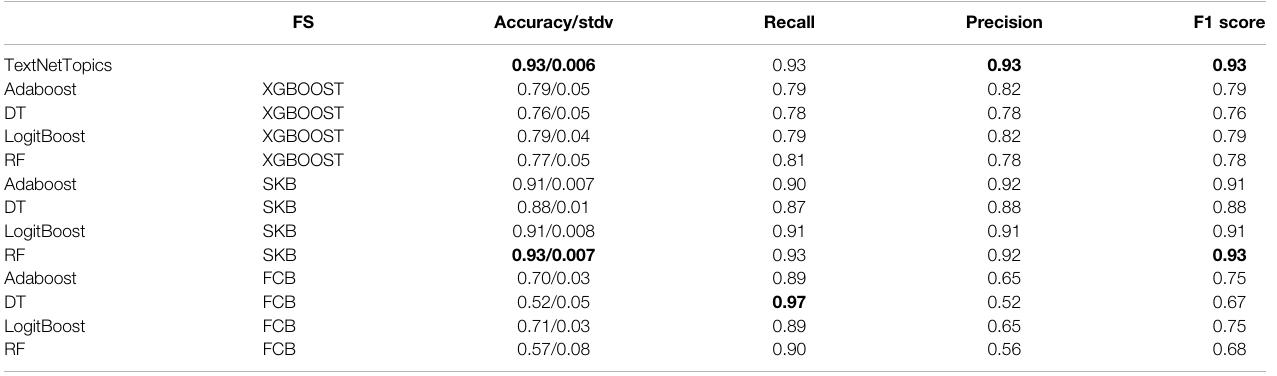
TABLE 6 | Results for different algorithms with different feature selections applied to the CAMDA dataset. The top 100 features are considered for each feature selection algorithm. The standard deviation of the accuracy is present in the Accuracy column after the “ slash ” sign. FS Accuracy/stdv Recall